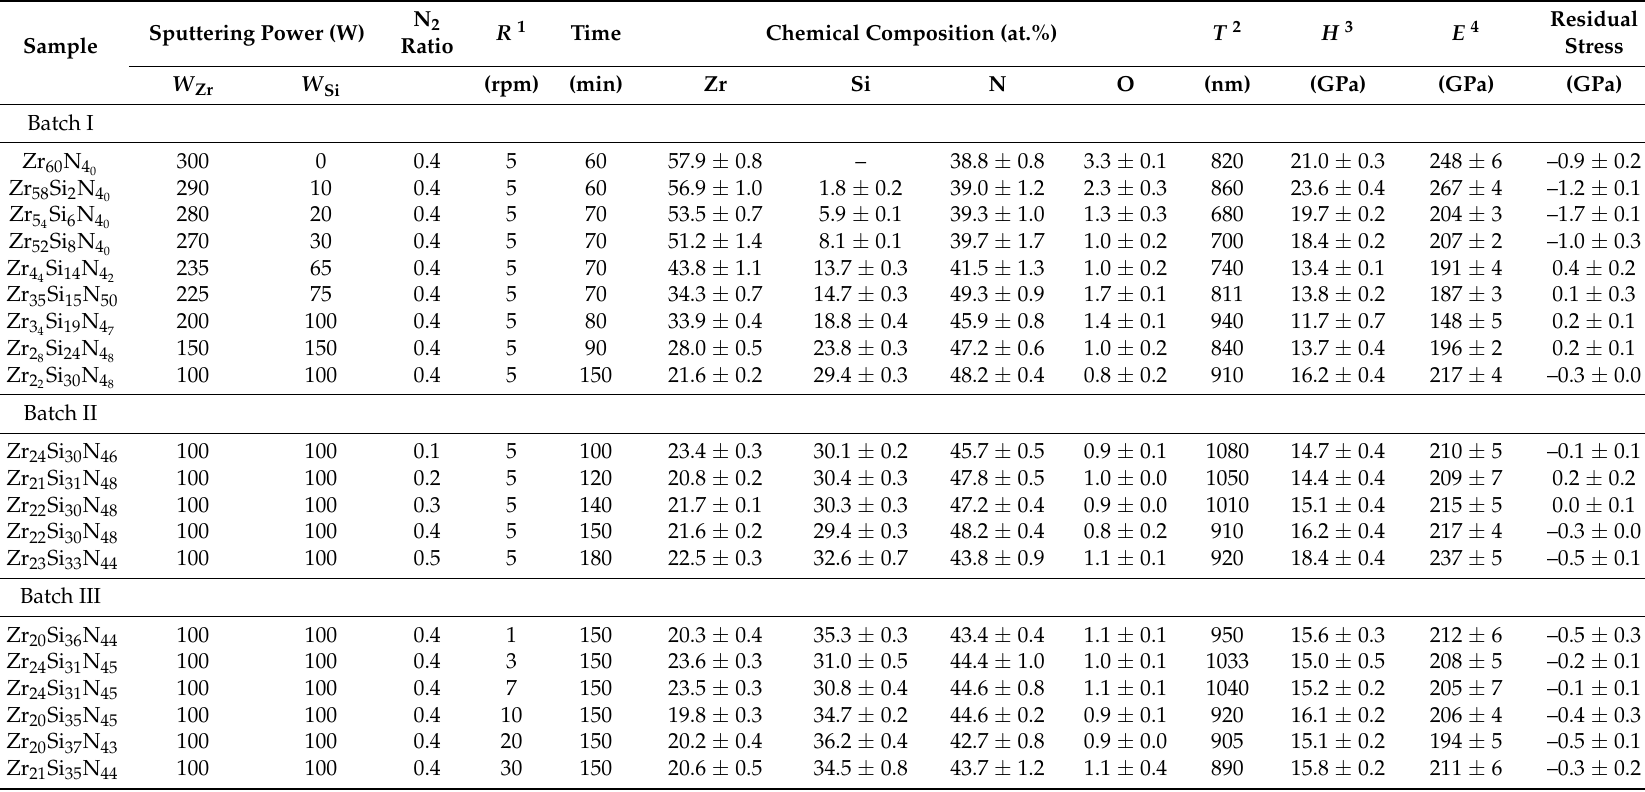
Table 1. Sputtering parameters, chemical compositions, thicknesses, mechanical properties, and residual stresses of Zr–Si–N